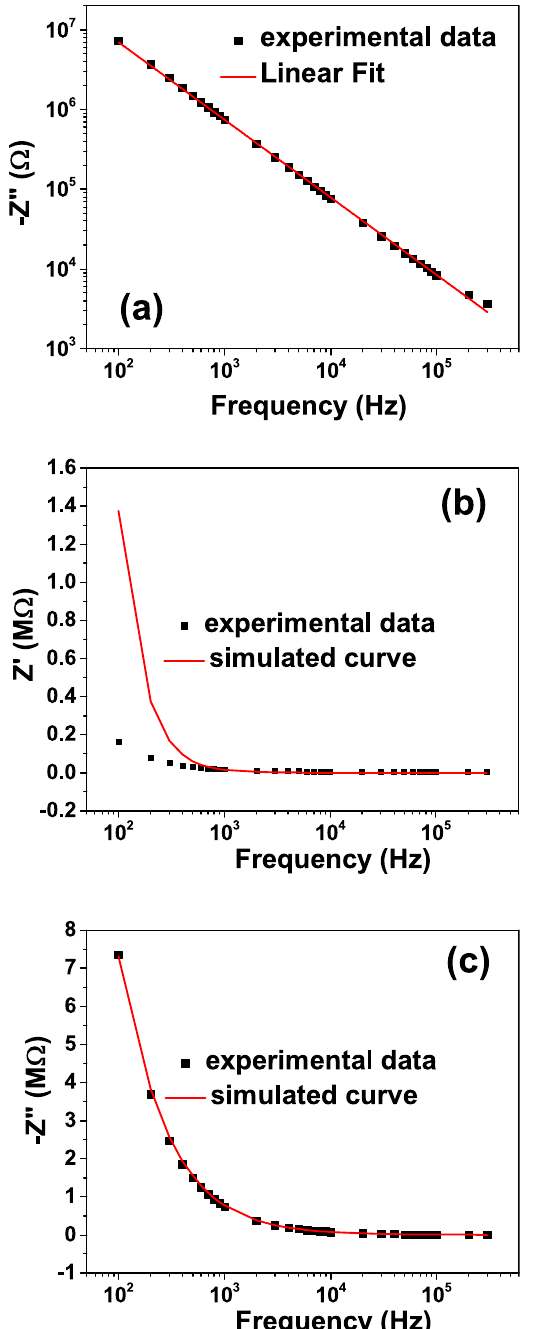
Figure 5. ( a ) log-log plot of frequency dependence of Z ″ ; Simulated curve using the equivalent circuit from Fig. 4(c) along with the experimental data obtained for ( b ) Z ′ and ( c ) Z ″ with V DC = 0 V and no external magnetic